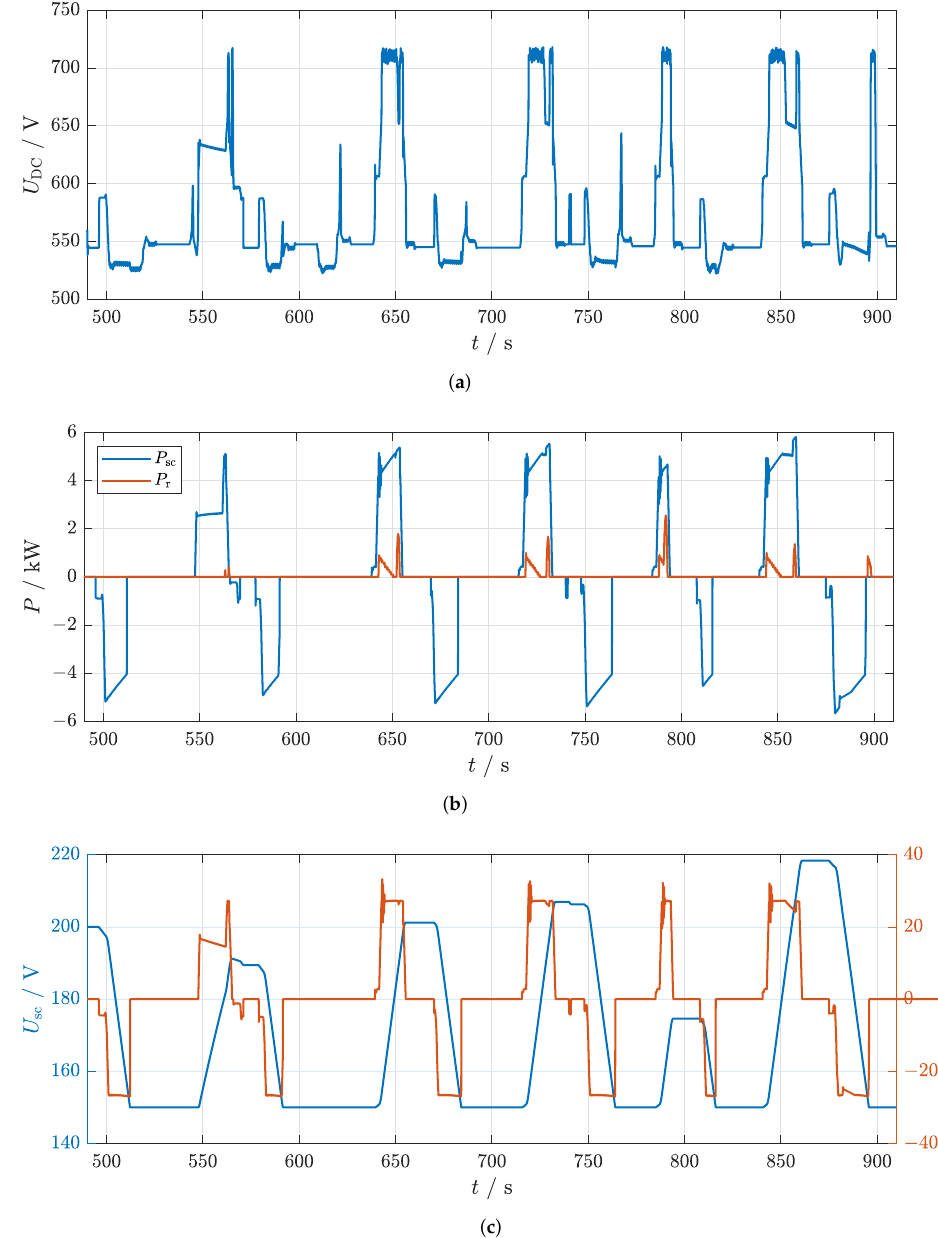
Figure 16. Simulation results for real traffic data. ( a ) DC bus voltage. ( b ) SC bank power and braking resistor power. ( c ) Voltage and current of the SC